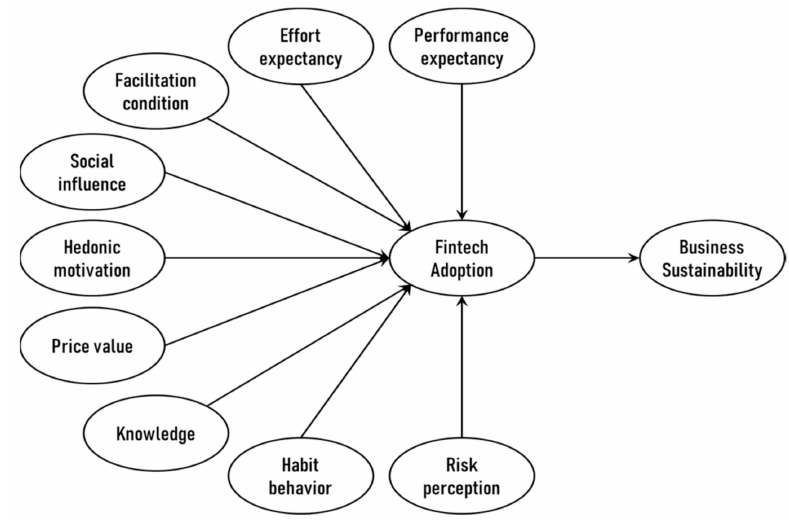
Figure 1. Initial model for FinTech adoption by small